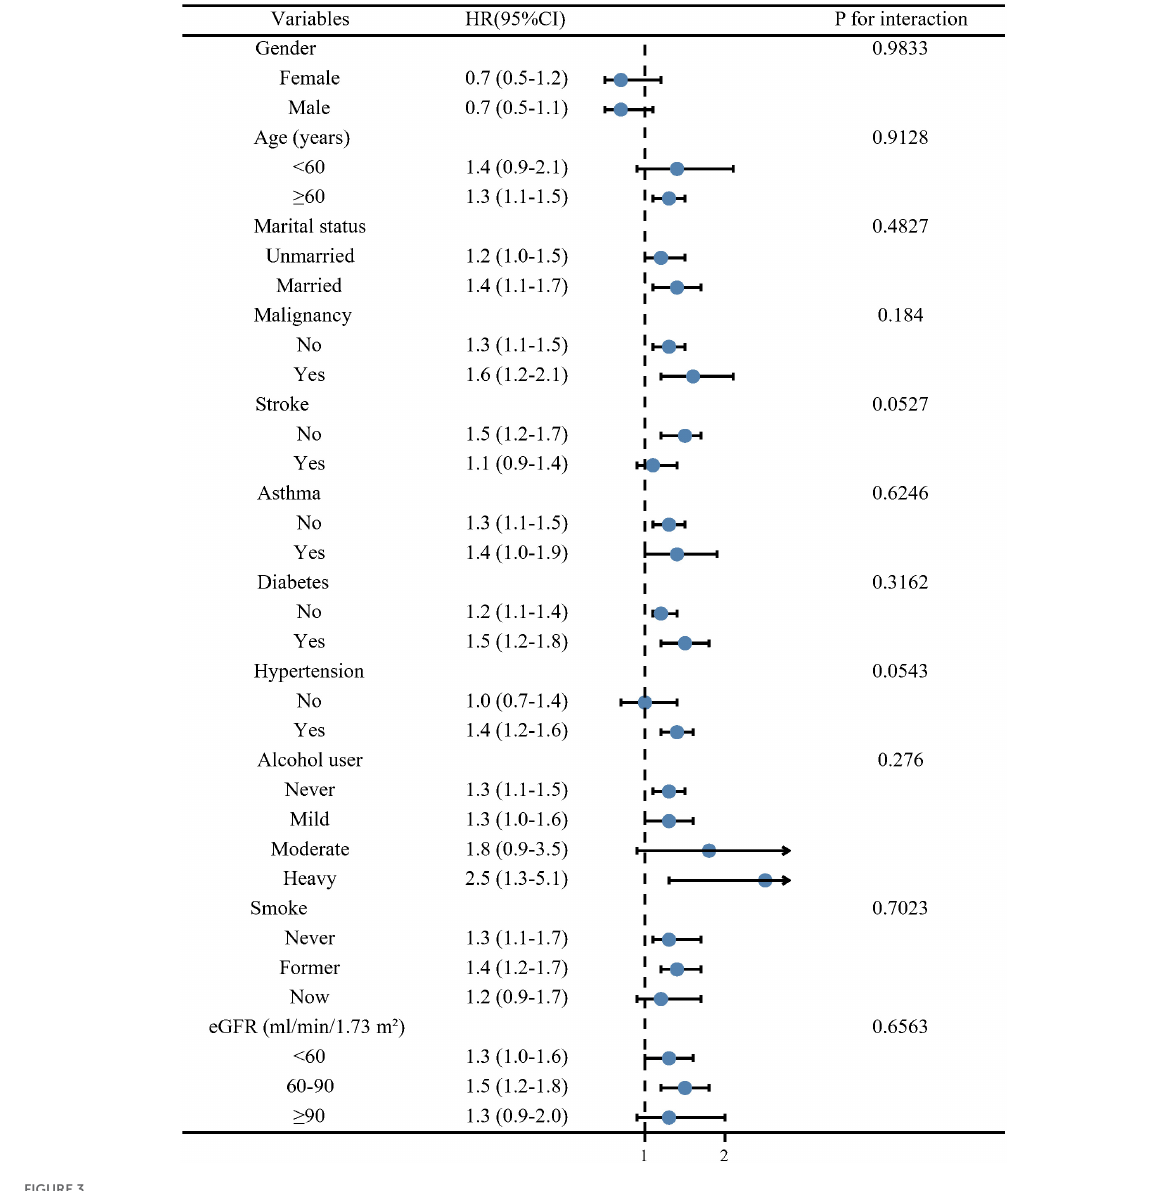
Frontiers in Cardiovascular